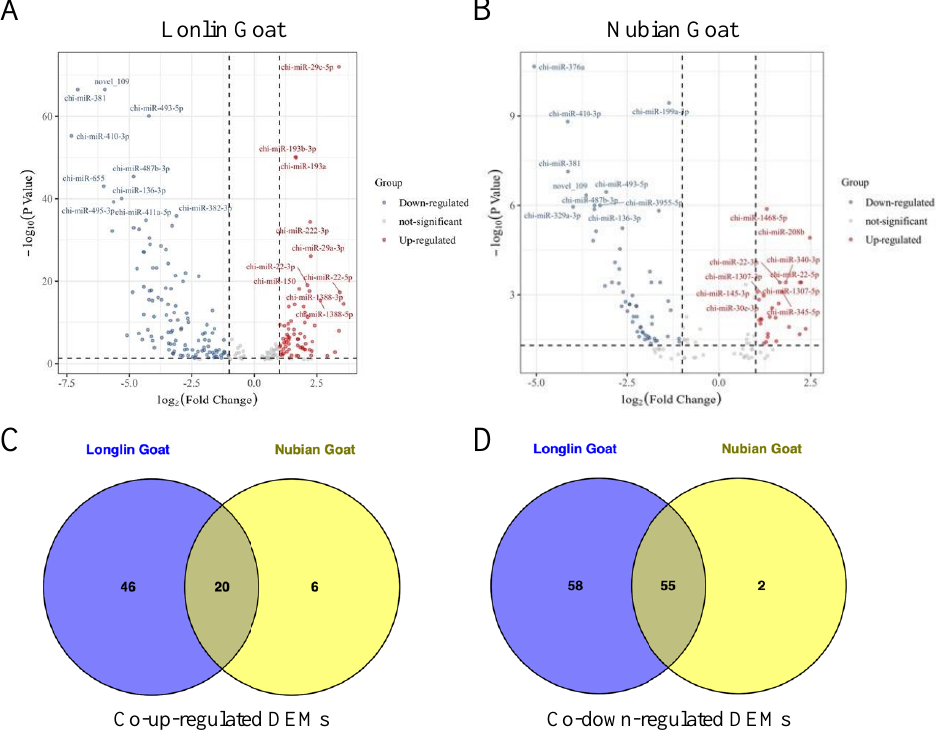
Figure 4. Identification of DEMs between 1-month-old and 10-month-old Longlin and Nubian goat. ( A ) Volcano plots of up-regulated and down-regulated DEMs of longissimus dorsi between 10-month-old and 1-month-old Longlin goat. The gray dots represent non-significantly DEMs, the 66 red dots represent significantly differentially up-regulated miRNAs, and the 113 blue dots represent significantly differentially down-regulated miRNAs. ( B ) Volcano plots of up-regulated and down-regulated DEMs of longissimus dorsi between 10-month-old and 1-month-old Nubian goat. The gray dots represent non-significantly DEMs, the 26 red dots represent significantly differentially up-regulated miRNAs, and the 57 blue dots represent significantly differentially down-regulated miRNAs. ( C ) Venn diagram showing the intersection of the co-up-regulated DEMs between Longlin and Nubian goat. ( D ) Venn diagram showing the intersection of the co-down-regulated DEMs between Longlin and Nubian goat.